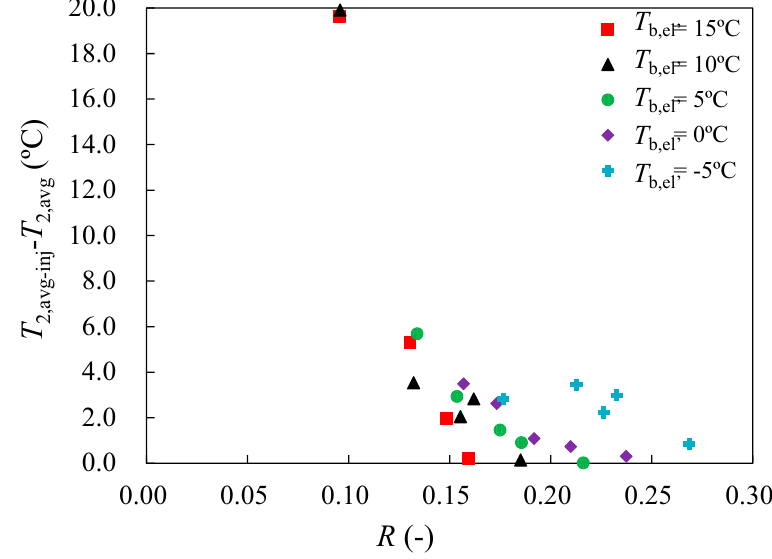
Figure 16. The normalized mass flow rate of the refrigerant ṁ avg-inj / ṁ avg with the injection ratio R in the vapor injection heat pump cycle.